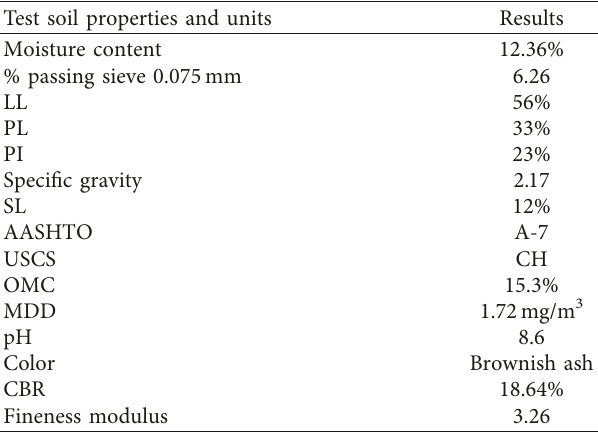
Table 6: XRF result for natural soil characterization.